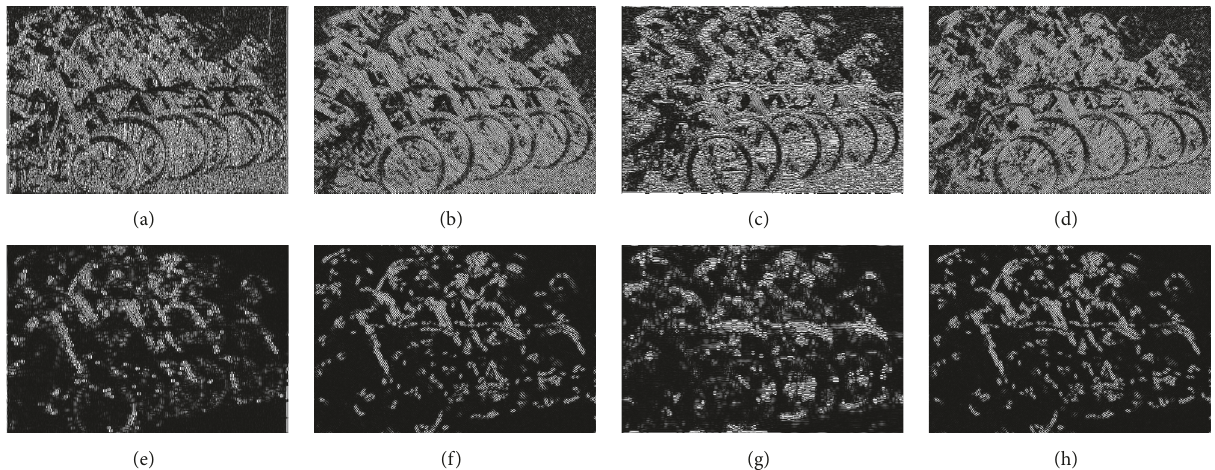
Figure 4: The magnitude maps of the log Gabor filter responses of an enhanced original image and its distorted